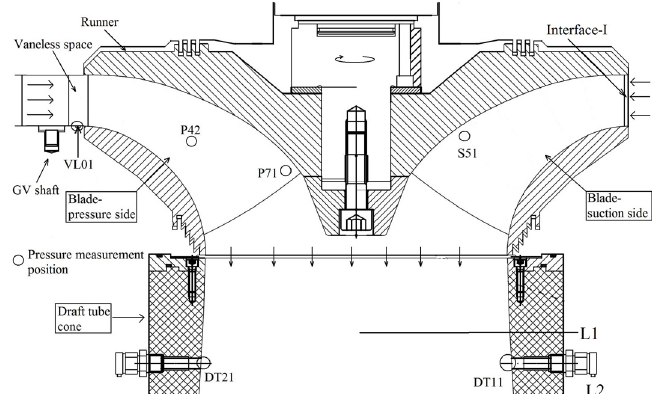
Fig. 1. Locations of the mounted pressure sensors in the model Francis turbine during measurements at the BEP, HL, and PL; VL01- vanless space, P42-blade pressure side, P71-blade trailing edge, S51-blade suction side, DT11 and DT21-draft tube; L1 and L2 correspond to the measurement sections